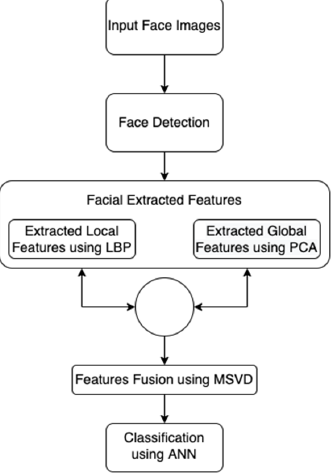
Fig. 1. Architecture of the